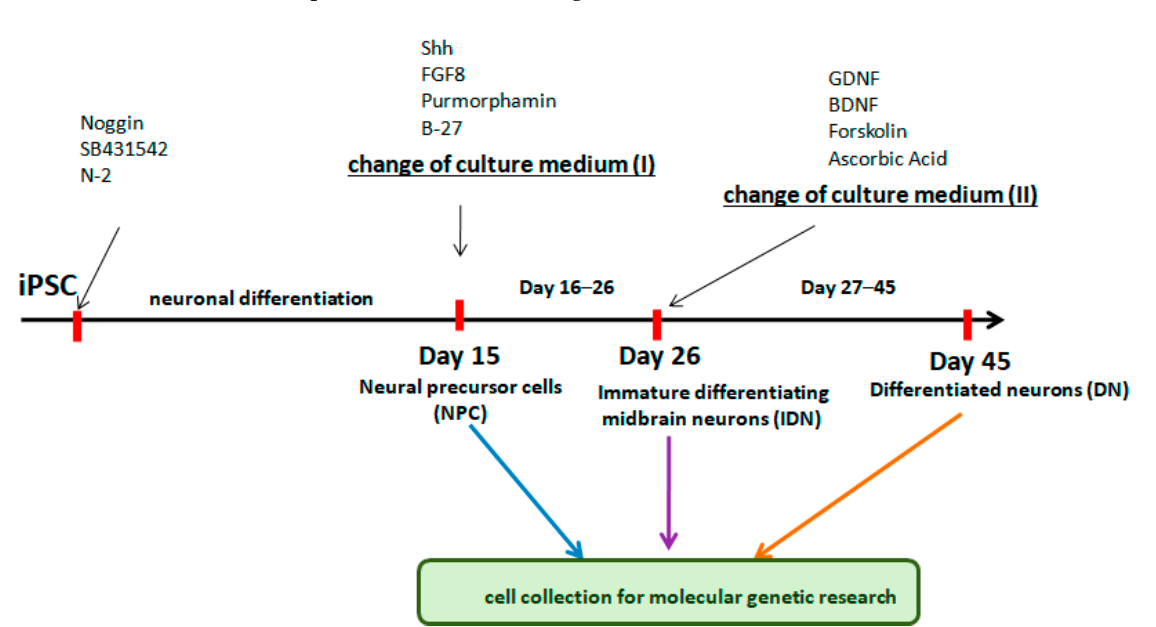
induced pluripotent cells (iPSCs). The MG coating served as a comparison. A schematic of the experiment is shown in Figure 1.